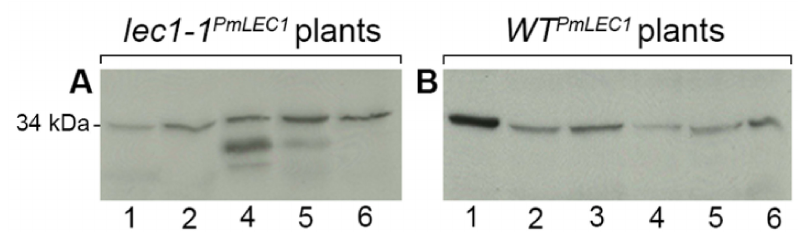
Figure 7. Western blot analysis of heterologous PmLEC1 peptide accumulation in transgenic Ara- bidopsis T2 plants. Total protein lysates were isolated from ( A ) second generation transgenic lec1-1 null mutant plants transformed with PmLEC1 (lane numbers correspond to the plants in Figure 4A) and ( B ) second generation wild type plants transformed with PmLEC1 (lane numbers correspond to the plants in Figure 6A). The protein samples (20 µ g) were separated by SDS-PAGE, transferred to a PVDF membrane and incubated with polyclonal anti-PmLEC1 serum diluted 1:1000 for 1